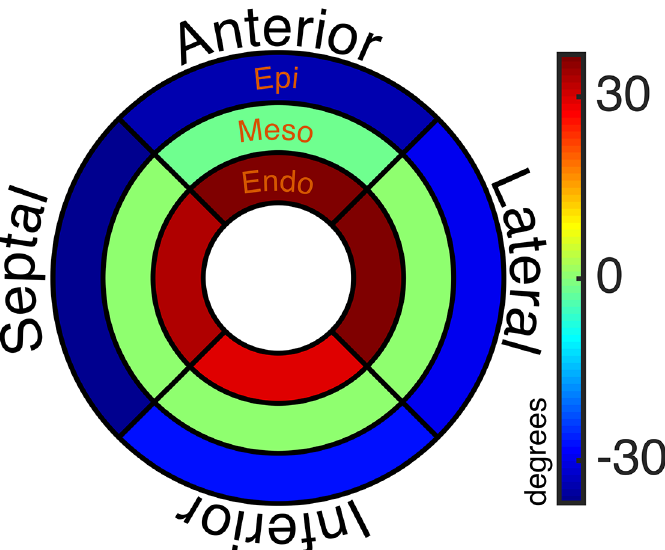
Fig 2. Colour coded Bullseye plot of mean helical angle values per transmural layer and regional wall. The inner, middle and outer rings represent the endo, meso and epicardium respectively. The upper, right, lower and left segments represent the anterior, lateral, inferior and septal walls